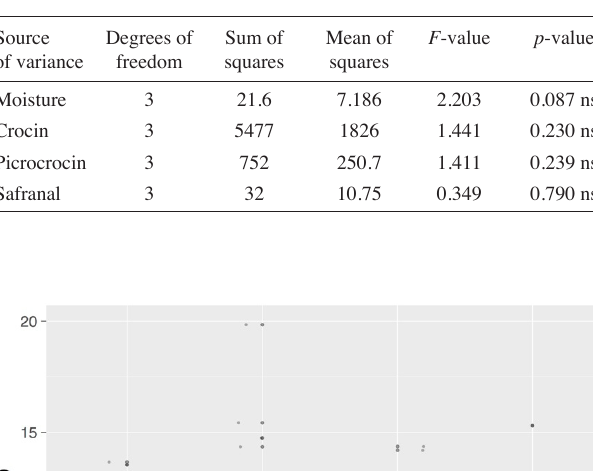
Tab. 2: One-way ANOVA results. The effect of year of production on mois- ture, crocin, picrocrocin and safranal is shown. Key: ns, not signifi- cant ( p > 0.05).